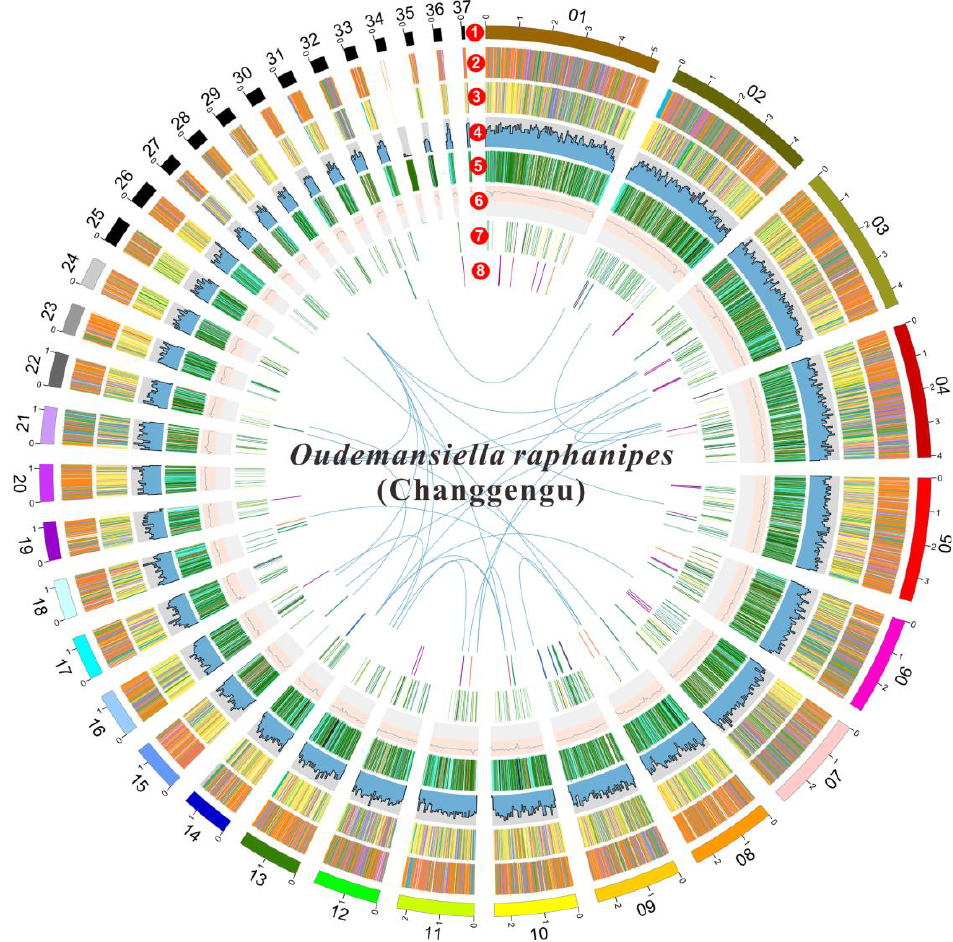
Figure 2. Circle map of the genome assembly and gene prediction of O. raphanipes CGG-A-s1. A total of seven layers were plotted from the outside to the inside. The outmost layer one is a circular representation of the 37 contigs with size intervals of 1 Mb. Layers two and three represent the predicted genes in the forward and reverse strands of the genome. Layer four indicates the gene density. Layer five indicates the repeat sequences. Layer six represents the GC content. Layer seven represents the genes of CAZymes. Links within and between chromosomes indicate collinear blocks generated from MCScanX: terpene (purple), NRPS or NRPS-like (green), fungal-Ripp-like (blue), T1PKS (orange), NRPS-independent-siderophore (red), indole (light orange), both of fungal-RiPP-like and terpene (light blue).